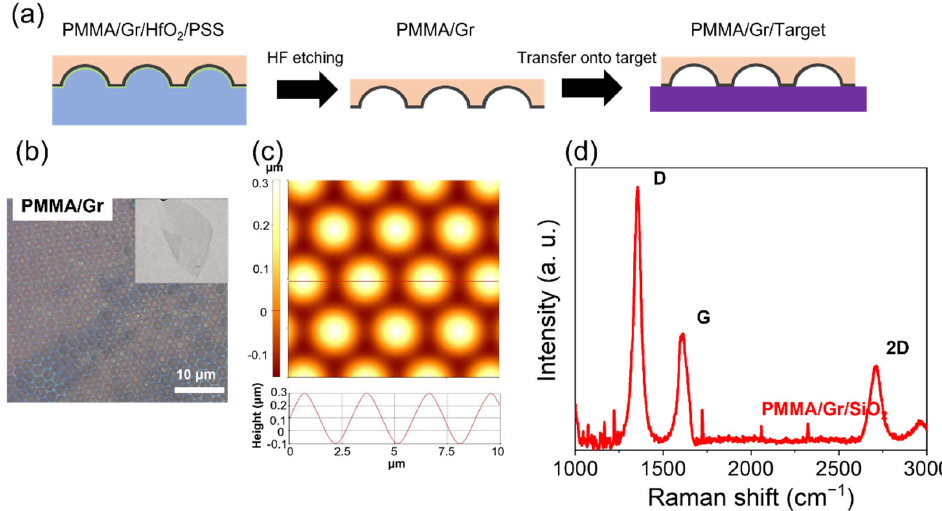
Figure 3. ( a ) Schematic of the transfer process of the flexible 3D Gr via wet-etching method. ( b ) Optical microscopy image of PMMA/Gr after HF etching. Inset: photograph of the flexible free-standing PMMA/Gr. ( c ) AFM image and ( d ) Raman spectrum of the transferred flexible 3D Gr.